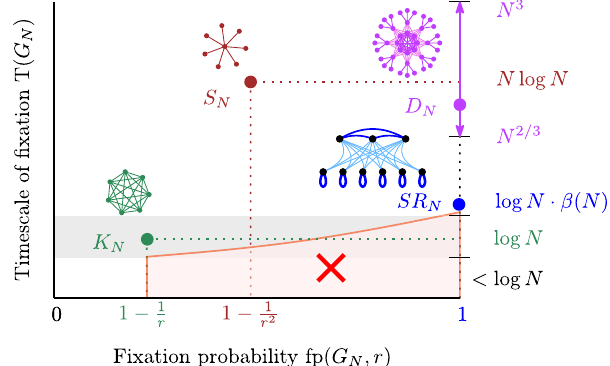
Fig. 1 Probability-timescale landscape of population structures. On a large well-mixed population ( K N , green), a single mutant with a fi xed relative fi tness advantage r > 1 fi xates with a constant probability 1 − 1/ r after a number of generations that scales logarithmically with the population size N . On a Star graph ( S N , brown), the fi xation probability increases to 1 − 1/ r 2 , in timescale relative to K N . Dense Incubators ( D N , purple) push the fi xation